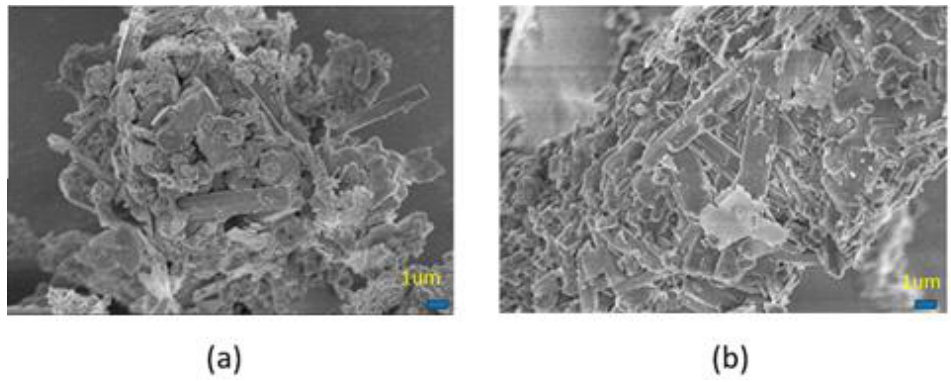
Figure 8. SEM images of the MKPCs ( a ) before, and ( b ) after calcination at 1000 °C for an hour. (magnesia/KH 2 PO 4 molar ratio = 4; wollastonite:vermiculite = 20:10 wt.%; aluminum trihydroxide = 10 wt.%).